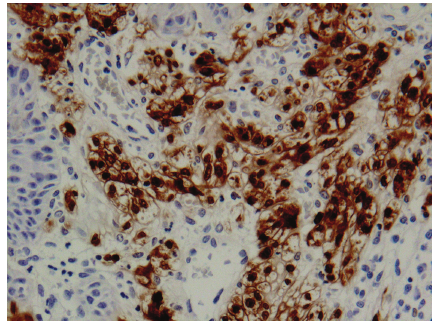
Figure 5: Immunoreactivity of the lesion for S-100